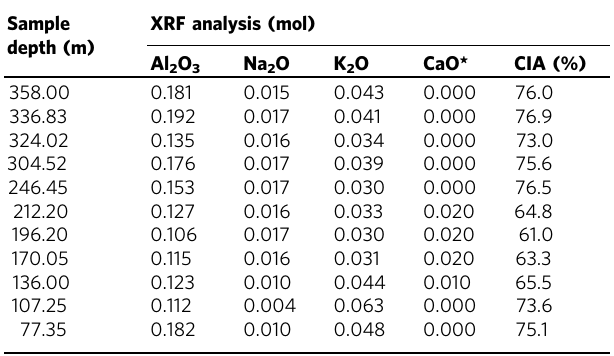
a Correction for carbonate and apatite made by using the method of 63 to estimate CaO for silicate fraction